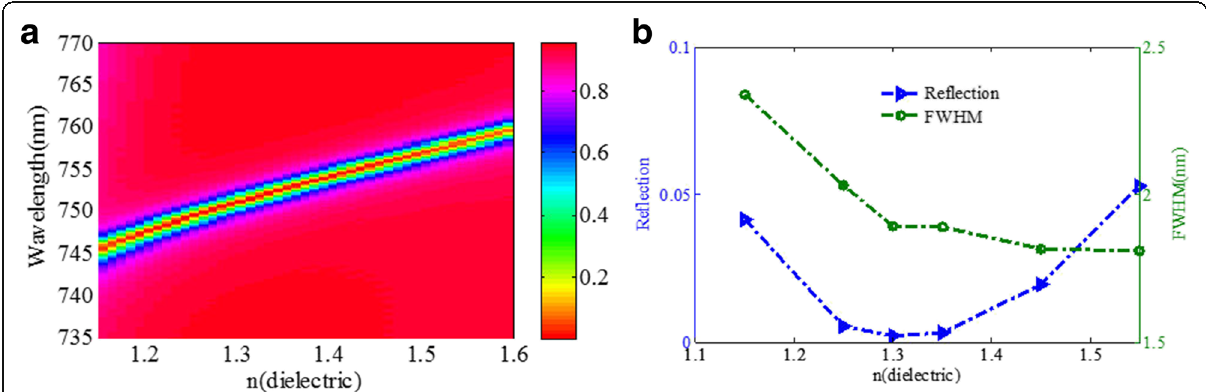
Fig. 7 a Reflection spectra as a function of the refractive index of the dielectric layer. b Reflectivity of the resonance dip and FWHM as functions of the refractive index of the dielectric